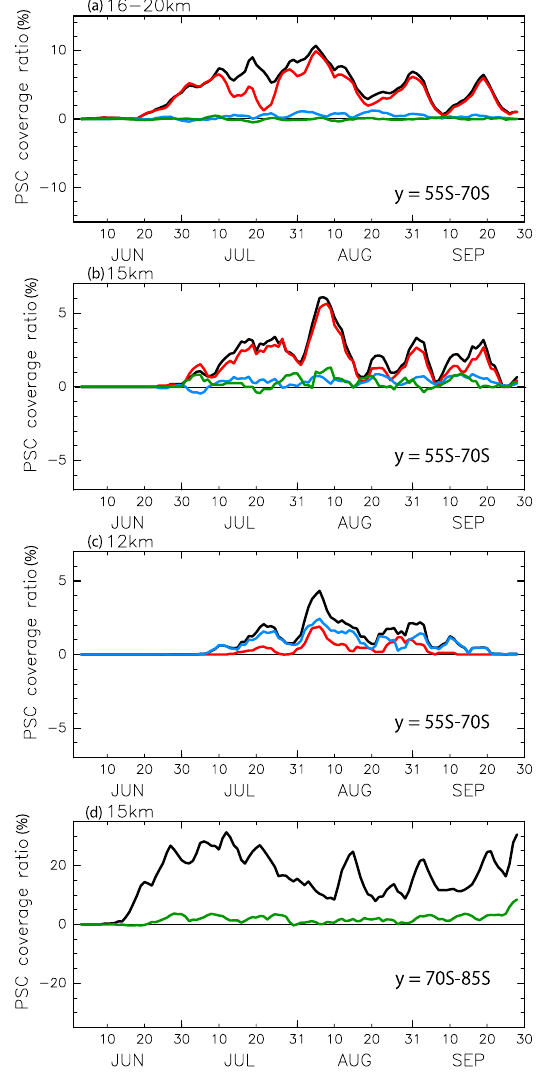
Fig. 11. Time series of 5-day-running means for 1R PW (red), 1R SW (blue) and 1R GW (green) in the latitude range of 55 ◦ S– 70 ◦ S at altitudes of (a) 16–20km, (b) 15km and (c) 12km. Black curves indicate R ALL . (d) The same as (b) but for 70 ◦ S–85 ◦ S. Only a result for gravity waves is